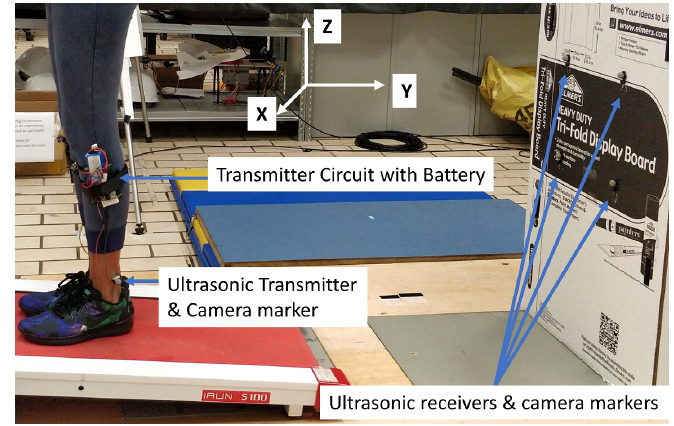
Figure 6. The setup for gait tracking with sensors attached to both lower limbs of the subject.